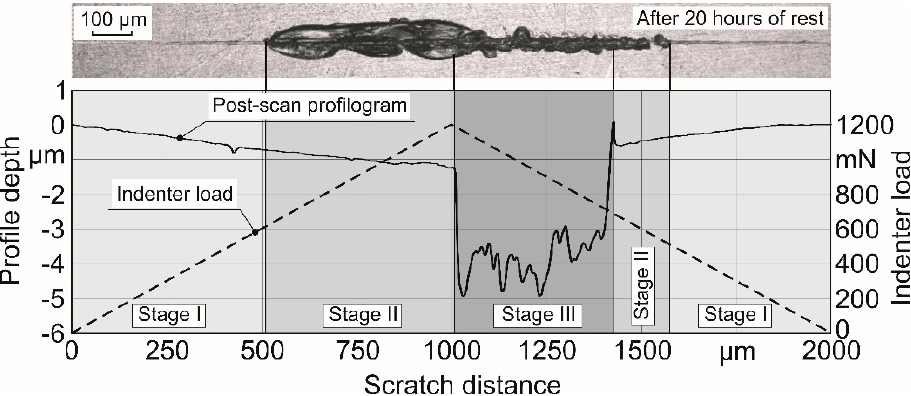
Figure 6. Diagrams and micro photo of the scratch in the obsidian glass by the progressive method.